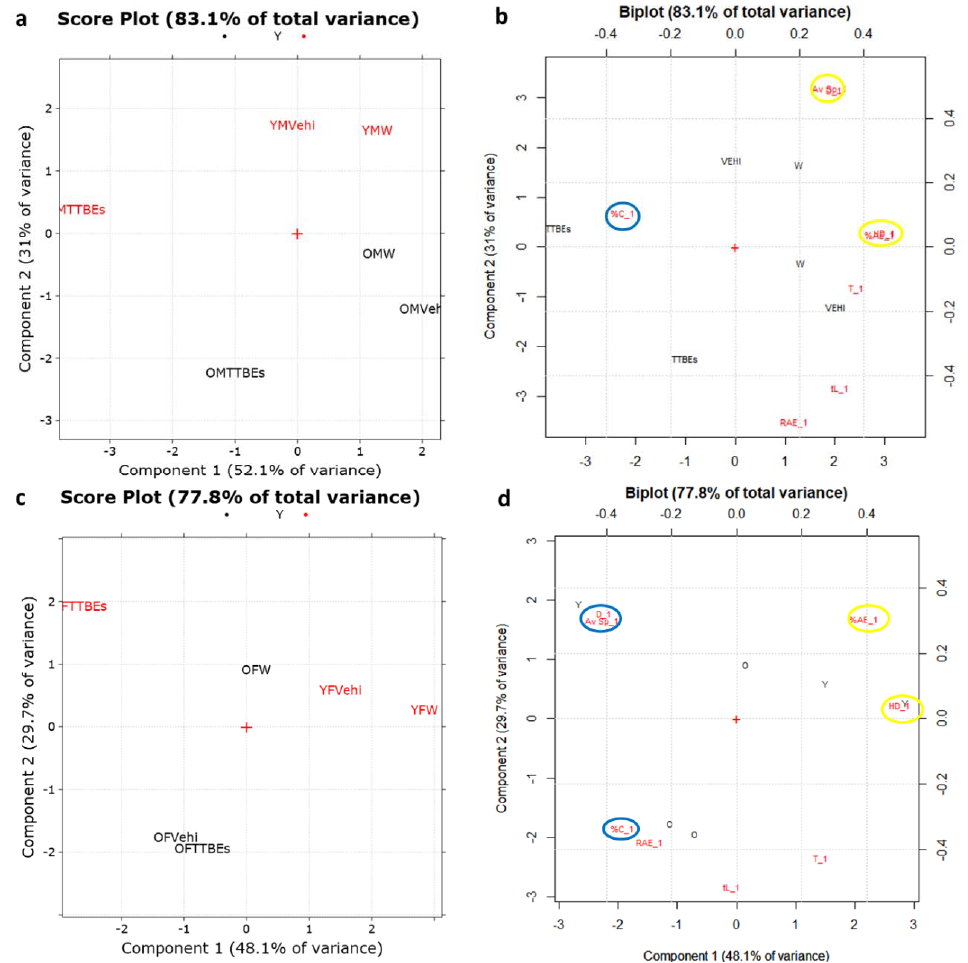
Figure 5. PC1 ‐ PC2 score plot ( a ) and biplot ( b ) of the M 16,8 data matrix. PC1 ‐ PC2 score plot ( c ) and Figure 5. PC1-PC2 score plot ( a ) and biplot ( b ) of the M 16,8 data matrix. PC1-PC2 score plot ( c ) biplot ( d ) of the F 16,8 data matrix. tL_1: time in light day 21 ‐ day 0, HD_1: head dippings day 21 ‐ day 0, and biplot ( d ) of the F 16,8 data matrix. tL_1: time in light day 21-day 0, HD_1: head dippings day AE_1: % of area explored day 21 ‐ day 0, RAE_1: exploration rate % day 21 ‐ day 0, %C_1: % of entries 21-day 0, AE_1: % of area explored day 21-day 0, RAE_1: exploration rate % day 21-day 0, %C_1: %